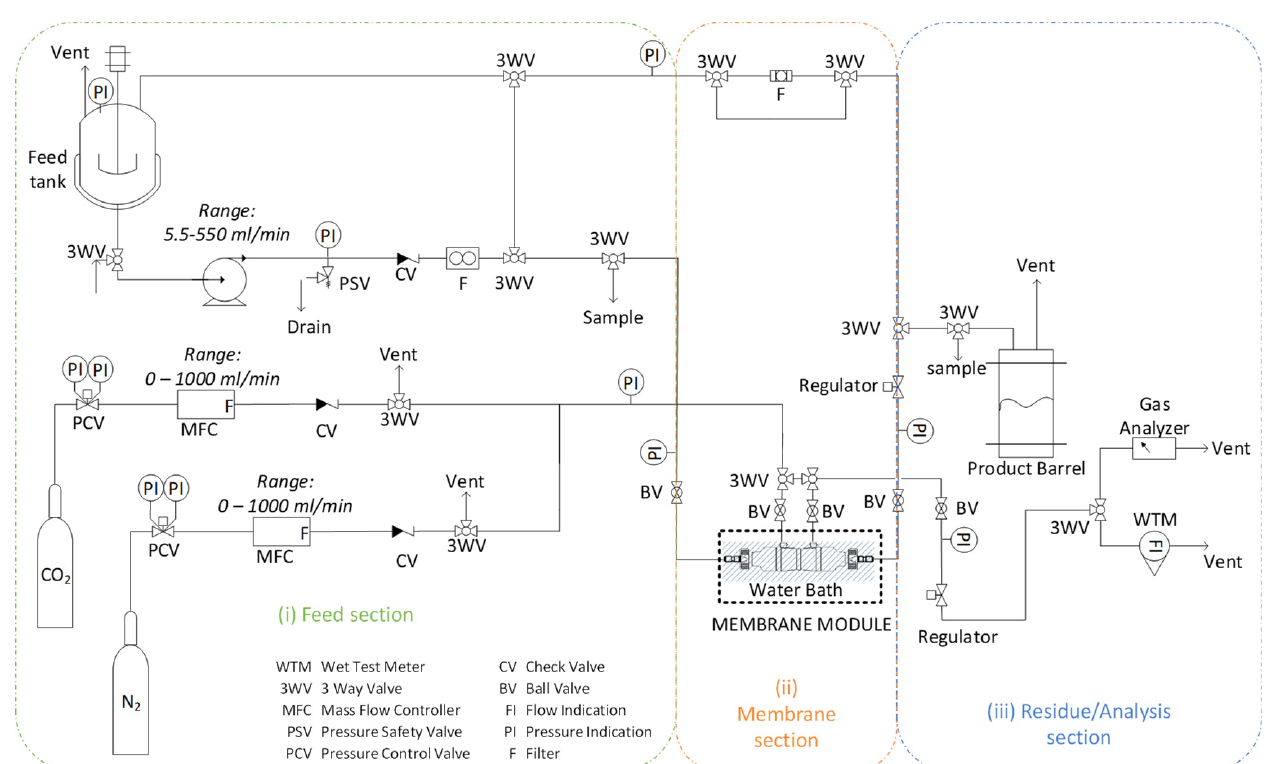
Figure 2. Schematic depiction of the lab-scale membrane reactor/precipitator experimental unit setup.